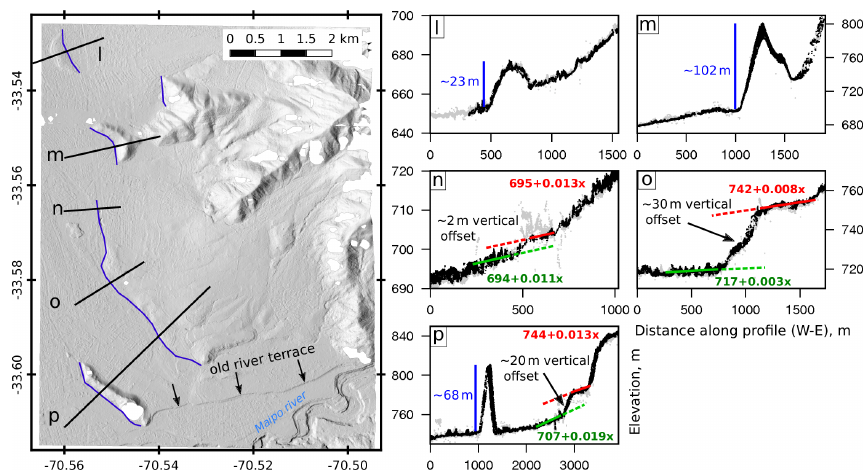
Figure 5. The southern section of the Pléiades DEM indicated in Fig. 3. The black points on the profiles are ground pixels from the Pléiades- imagery-derived point cloud, while the grey are from the SPOT point